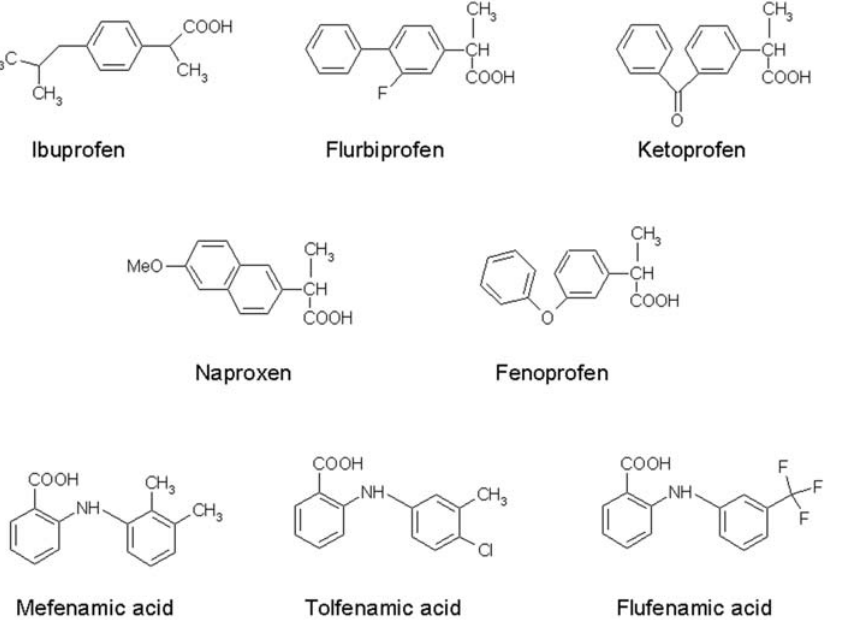
Figure 3. Chemical structures of NSAIDs lacking the diphenylamine moiety but still bearing a carboxylate function like ibuprofen, flurbiprofen, ketoprofen, fenoprofen and naproxen. Chemical structures of N-phenylanthranilic acid drugs containing the diphenylamine moiety like mefenamate, tolfenamate and flufenamate.